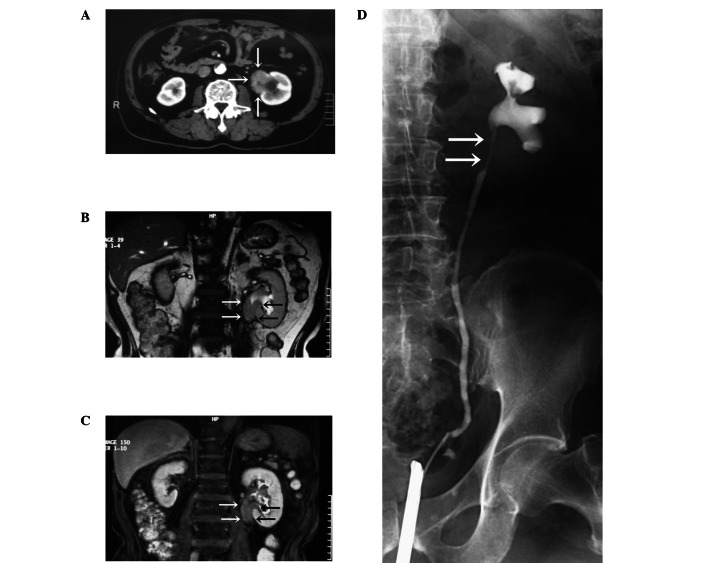
Imaging studies. (A) Abdominal computed tomography (CT) revealing a left hydronephrosis and diffuse pelvic wall thickening (arrows) that are enhanced slightly by contrast media. (B) T2-weighted magnetic resonance imaging (T2WI-MRI) demonstrating a mass-like lesion (arrows) surrounding the renal pelvis and upper ureter, whose signal intensity is slightly lower than that of the renal parenchyma. (C) Gadolinium-enhanced MRI reveals a poorly enhanced pyeloureteral junction with a thickened wall (arrows). (D) Retrograde pyelograpy shows a >3 cm narrowing of the upper ureter (arrows), and the surface of this area appears to be smooth.